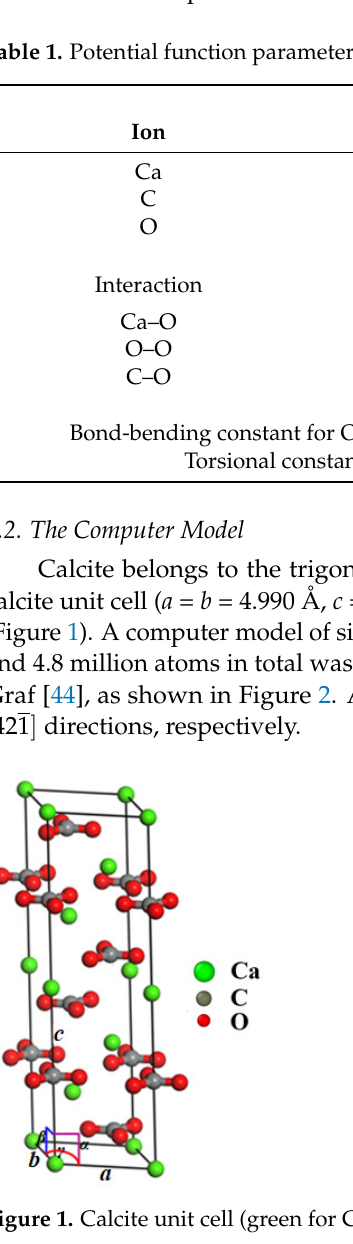
Table 1. Potential function parameters [34].